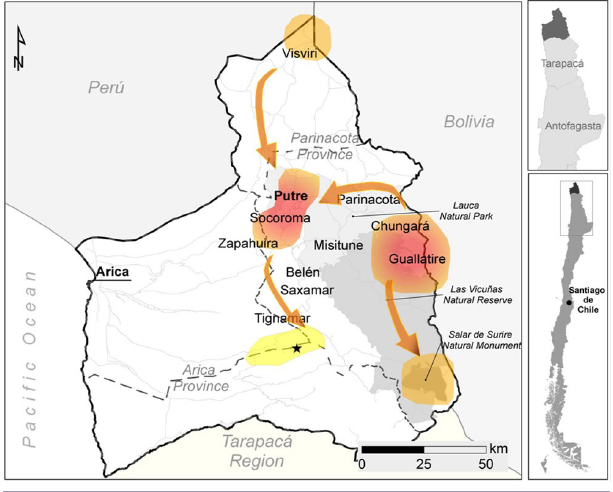
Fig. 1 . Study area in the Andes of northern Chile. Local residents generally identified large areas of the foothills where condors ( Vultur gryphus ) can be seen and possible places where they live higher up in the mountains. The areas most frequently mentioned were in the vicinity of Putre and Socoroma and the Guallatire Volcano, followed by the Visviri mountains and the Surire salt flat. Condors are believed to move across regions, from their source in the mountains down to the foothills through which they merely pass. Arrows: indicate the direction, described by interviewees, of the movement of condors during the day, from their resting to feeding places. Orange areas: resting and roosting places; red areas: daytime feeding places; yellow area: possible destination without personal sightings. The star indicates the location of the Condor Stone.